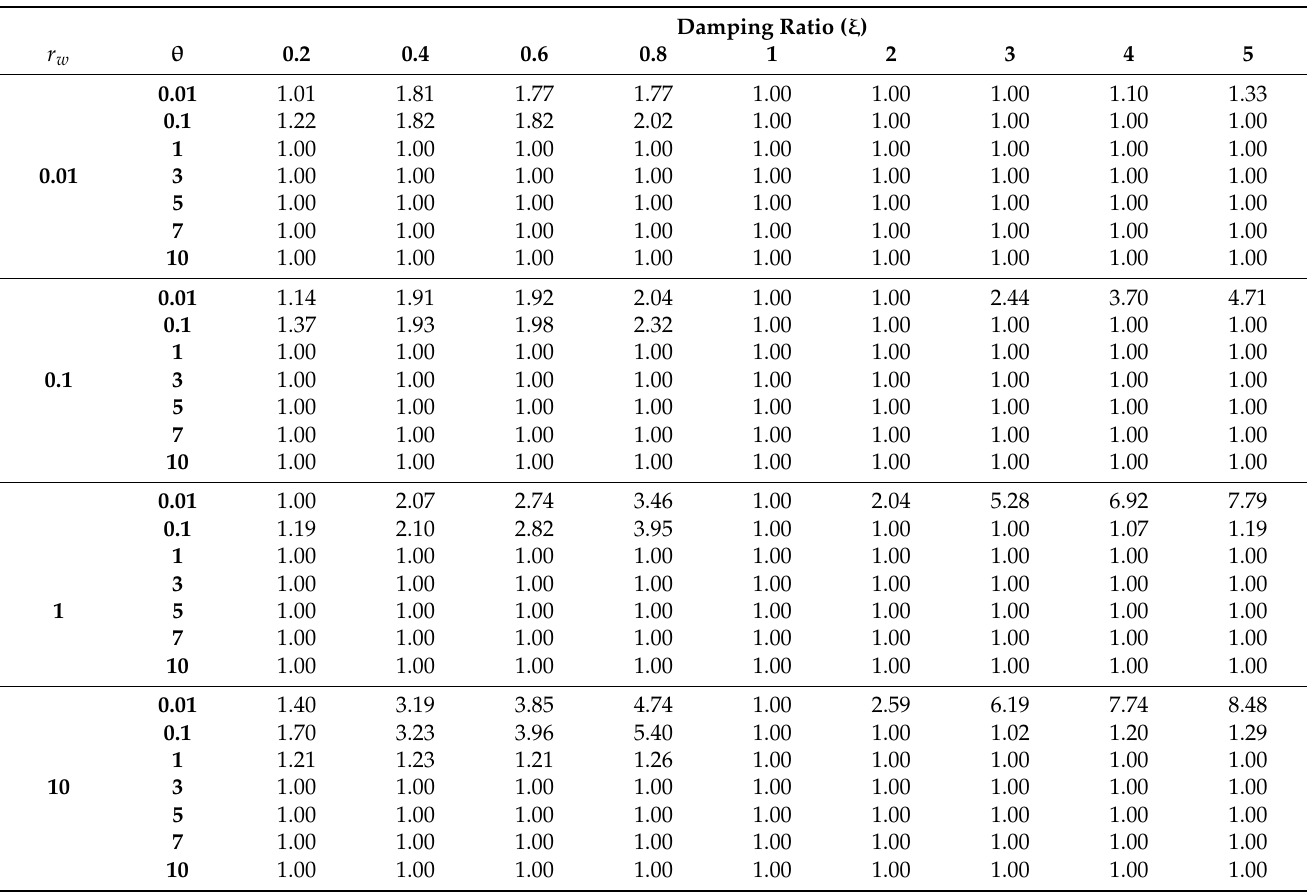
Table 8. Normalized IAE for MPC (Process 3, setpoint